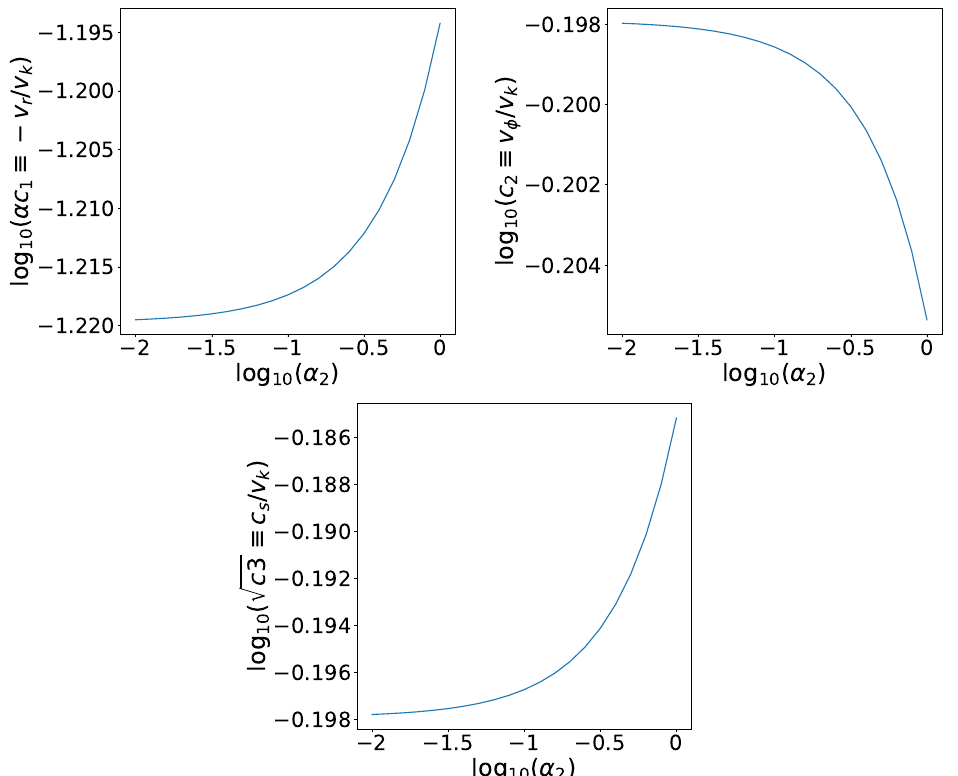
Figure 1. The properties of the accretion flow when outflow is absent ( s = − 1/2). The top-left panel plots radial infall velocity (in units of Keplerian velocity) as a function of the strength of anisotropic pressure ( α 2 ). The top-right panel plots rotational velocity (in units of Keplerian velocity) as a function of the strength of anisotropic pressure ( α 2 ). The lower panel plots sound speed (in units of Keplerian velocity) as a function of the strength of anisotropic pressure ( α 2 ). The viscous coefficient α 1 was set to be 0.1. The ratio of magnetic to gas pressure β was set to be